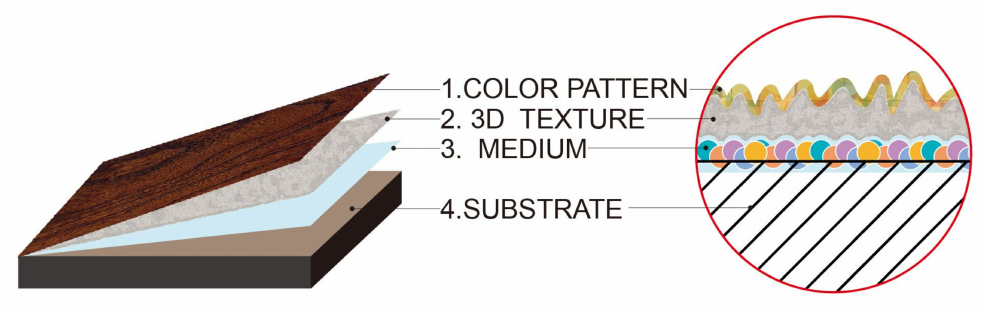
Figure 11. The model of UV printing wood